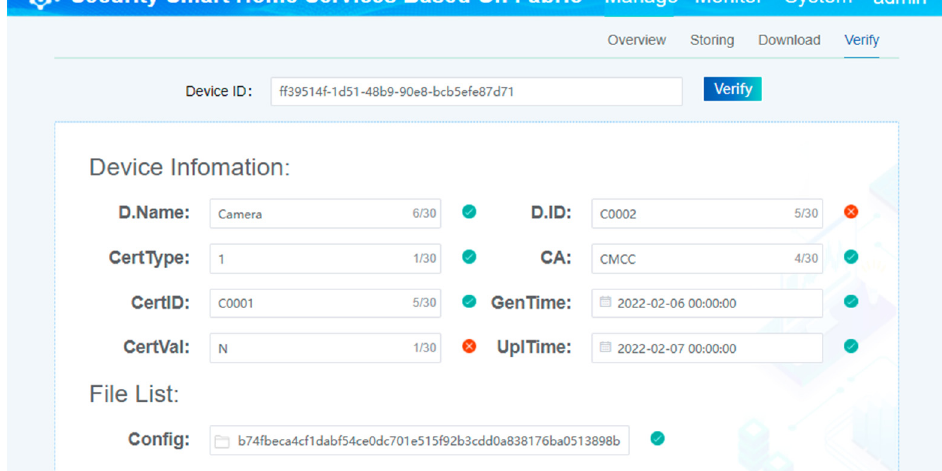
Figure 12. The process of verifying the current information based on the chain.